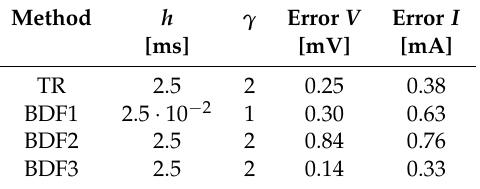
Table 7. RLC circuit: Low-precision configuration of the DAE integration methods.